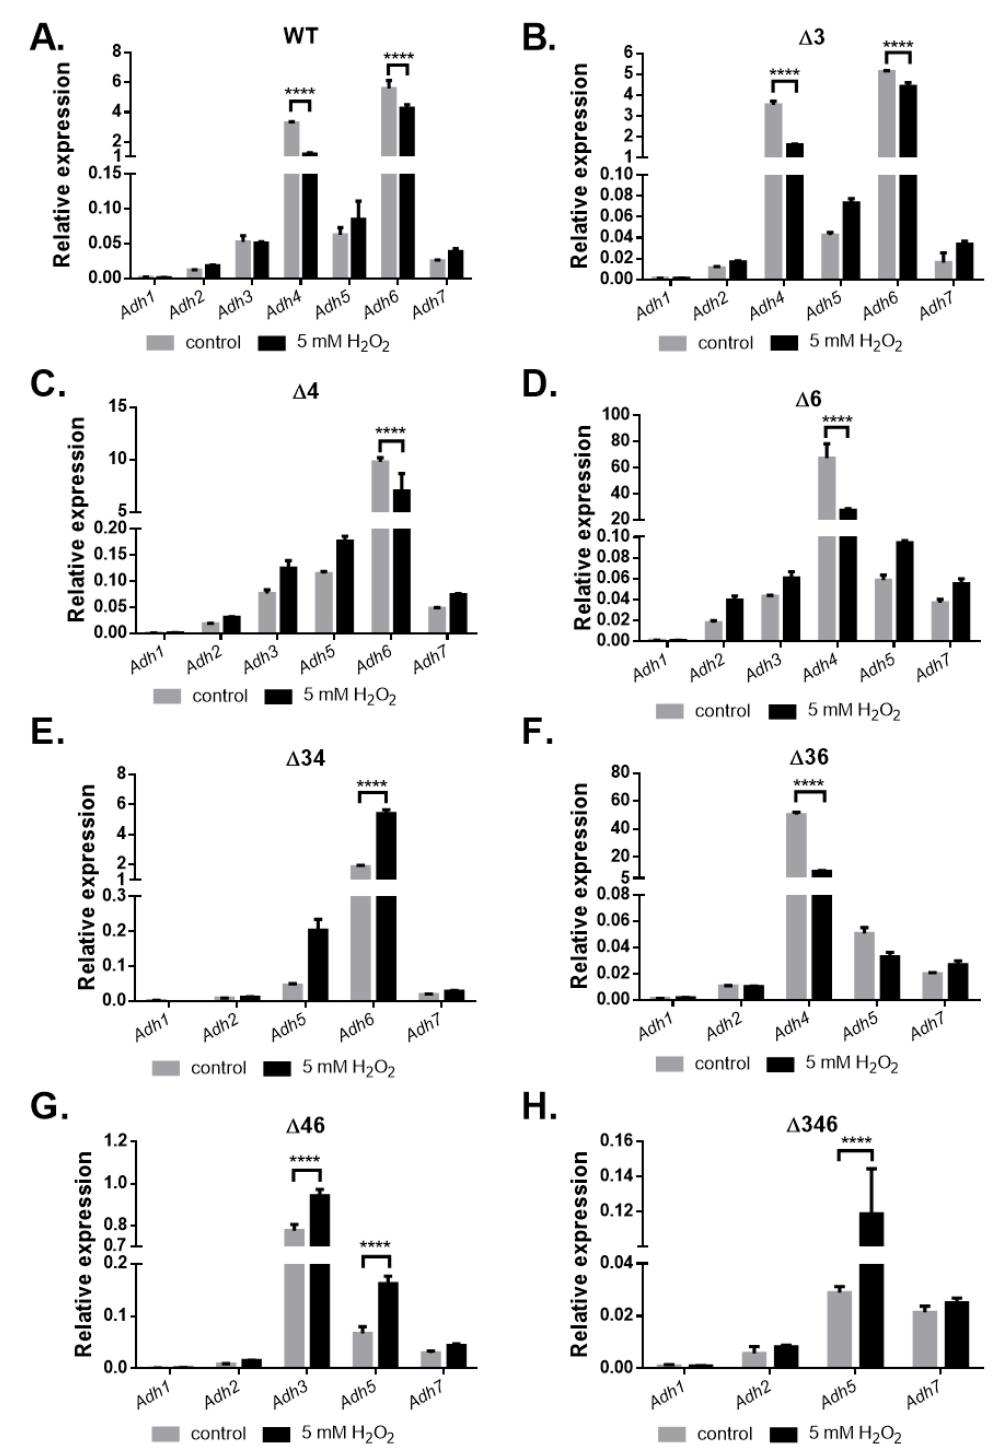
Figure 6. Relative gene expression of Adh genes in wild-type and mutant strains after treatment with H 2 O 2 for 20 min. Comparison of relative gene expression for A. baumannii ATCC 19606 ( A ) wild-type; ( B ) ∆ 3 single mutant; ( C ) ∆ 4 single mutant; ( D ) ∆ 6 single mutant; ( E ) ∆ 34 double mutant; ( F ) ∆ 36 double mutant; ( G ) ∆ 46 double mutant; and ( H ) ∆ 346 triple mutant strains cultured in M9 medium before (gray bar) and after 5 mM H 2 O 2 treatment for 20 min (black bar). Two-way ANOVA tests were conducted to assess statistical significance. **** p < 0.0001.